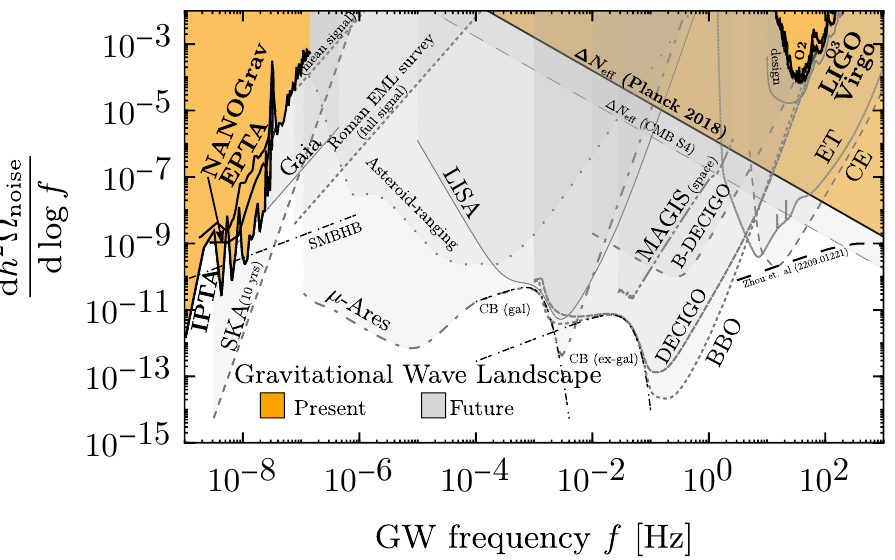
Figure 11 . Current and future prospects for detecting stochastic gravitational waves. For existing experiments we show the measured noise curves, while for future experiments we show the projected noise curves. See table 2 for references and assumptions utilizing these curves for the signal-to-noise analysis. Thin black dot-dashed curves are the expected astrophysical backgrounds, where it is currently unclear the prospects for extracting